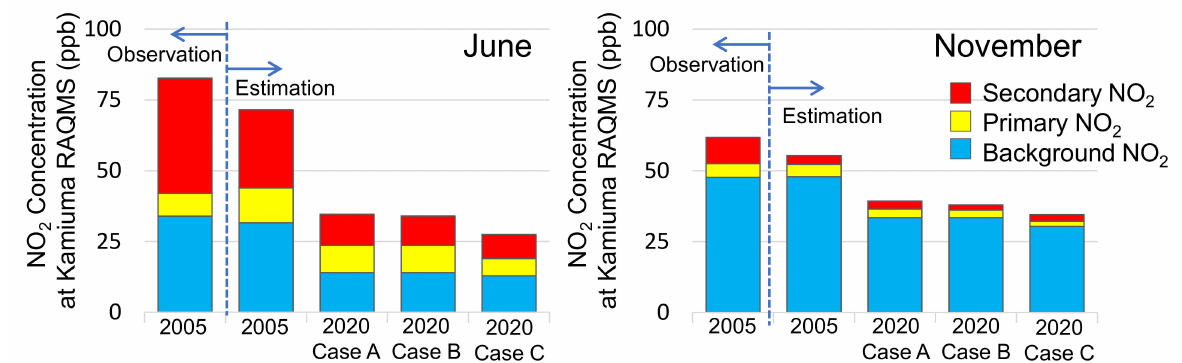
Figure 21. Simulation results of the Roadside Air Quality Model at the Kamiuma RAQMS.